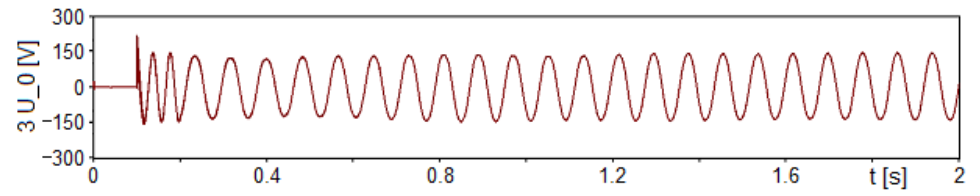
Figure 4. Waveform of the voltage at open delta terminals of the delta